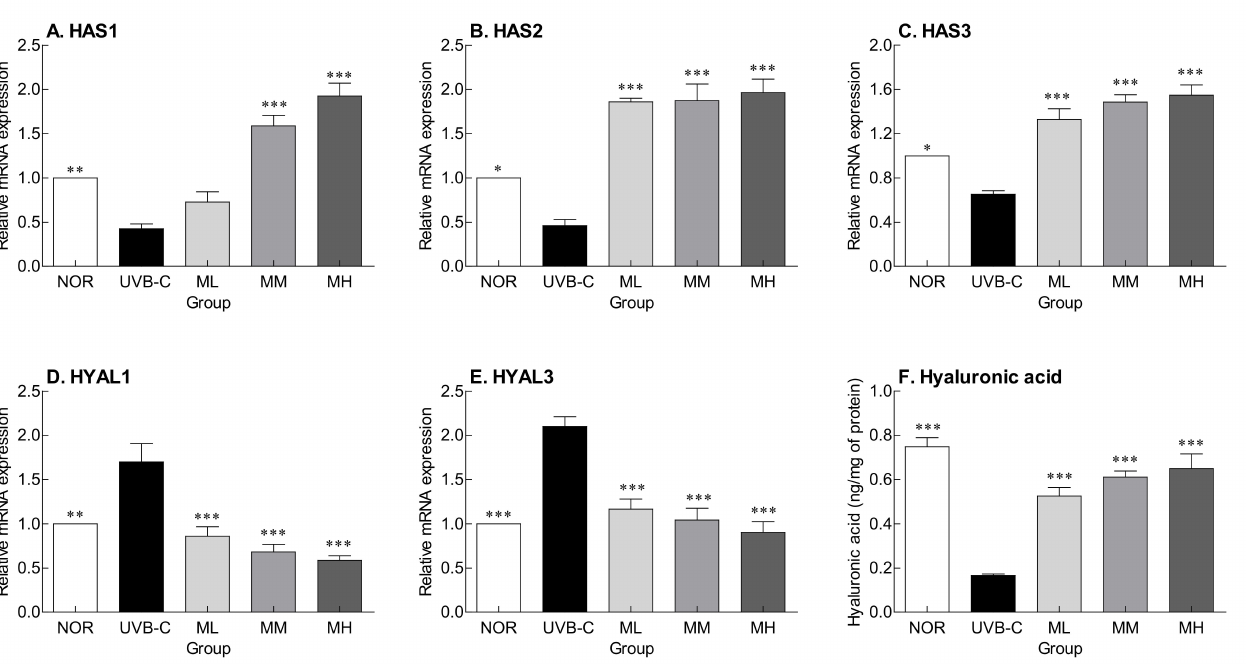
Figure 2. Effects of milk phospholipids on gene expression of HAS ( A – C ) and HYAL ( D , E ) and hyaluronic acid (HA) content ( F ) in UVB-irradiated hairless mice. NOR: oral administration of saline without UVB irradiation; UVB-C: oral administration of saline under UVB irradiation; ML: oral administration of low-dose (50 mg/kg b.w.) milk phospholipids under UVB irradiation; MM: oral administration of medium-dose (100 mg/kg b.w.) milk phospholipids under UVB irradiation; MH: oral administration of high-dose (150 mg/kg b.w.) milk phospholipids under UVB irradiation. Data are expressed as means ± standard error ( n = 6). * p < 0.05, ** p < 0.01, and *** p < 0.001 vs.